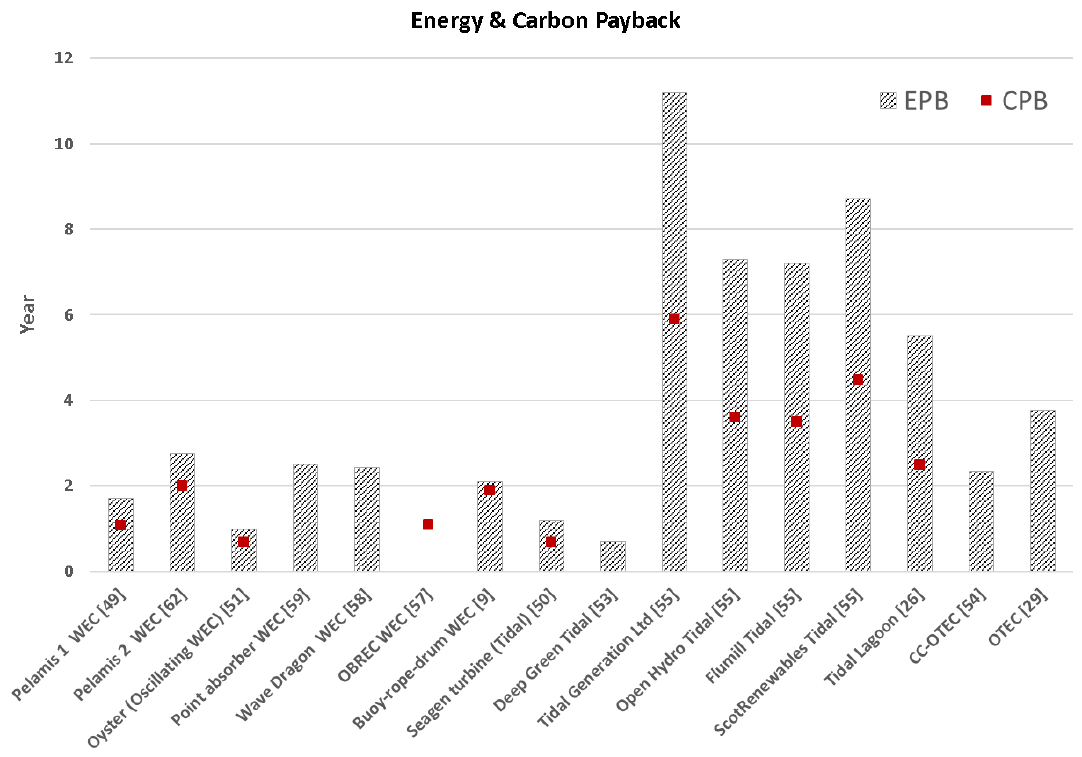
Figure 6. Energy payback period (EPB) and carbon payback (CPB) of ocean energy technologies.